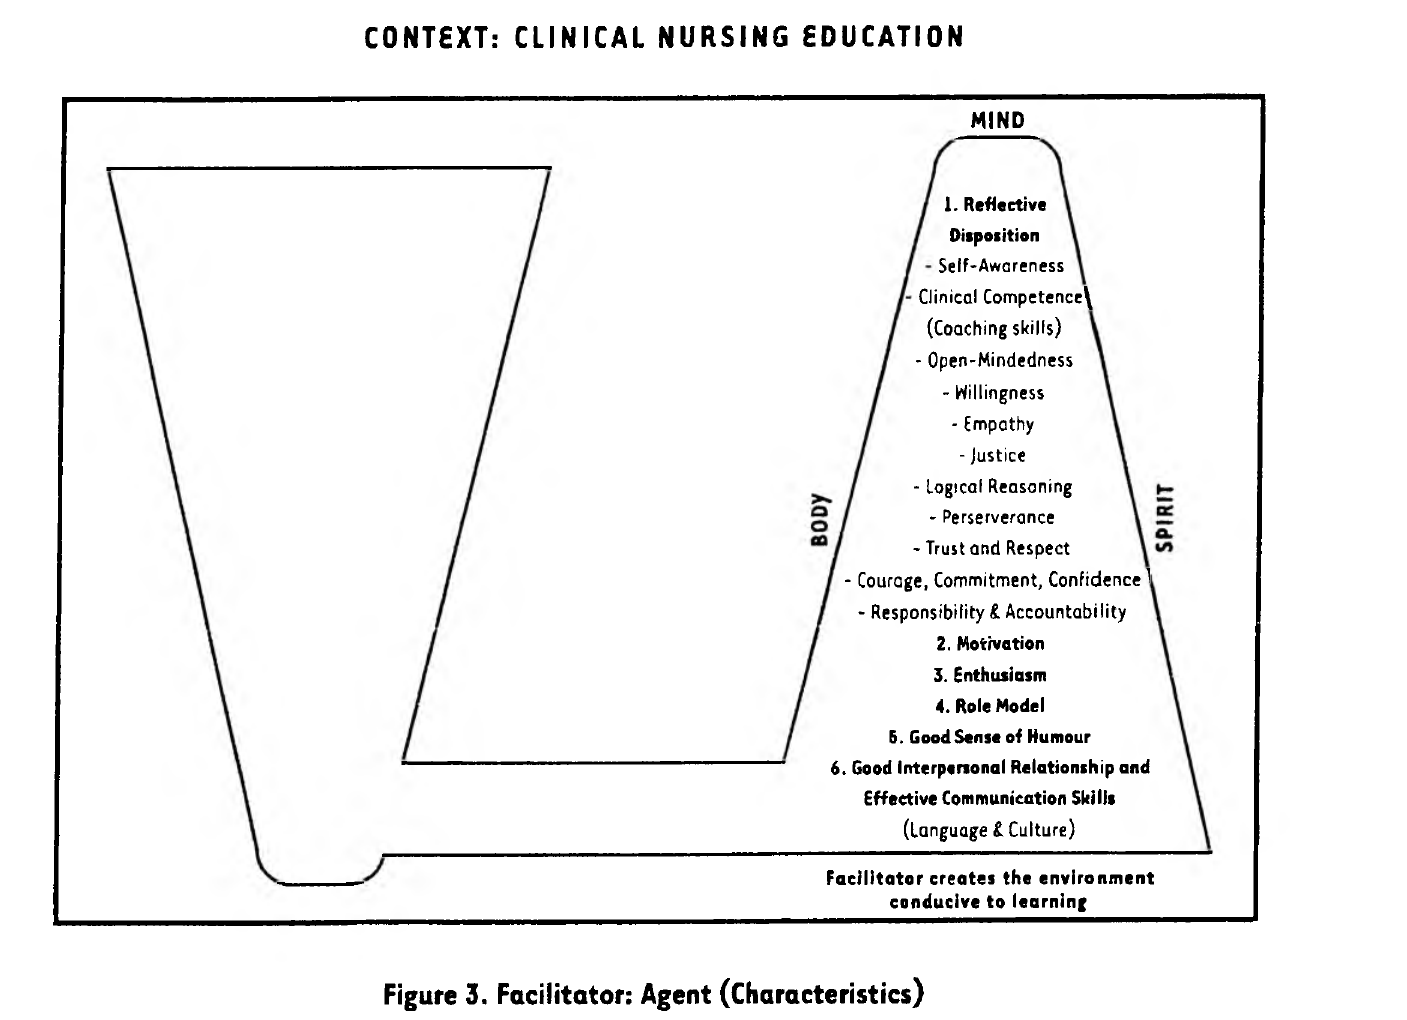
Figure 3. Facilitator: Agent